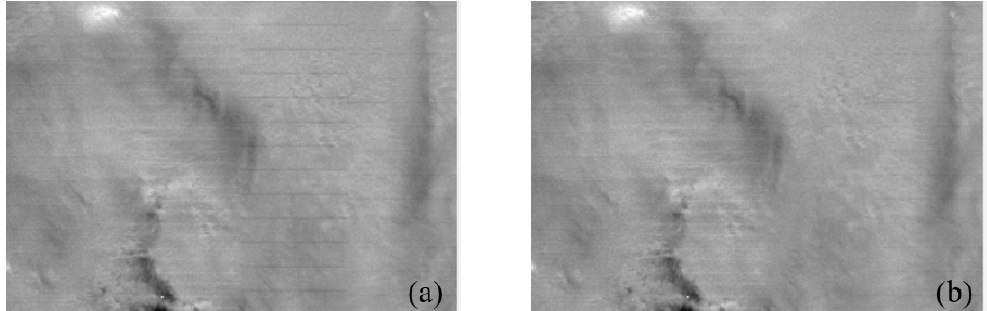
Figure 12. ( a ) Original NOAA-20 VIIRS DNB nighttime image recorded over North America at 8:13 UTC, December 29, 2020. The 208 × 296 (track × scan) pixels are in the upper left side of the granule (aggregation zones 15–19). ( b ) Reprocessed image using the updated NOAA-20 VIIRS DNB LGS Gains LUT.